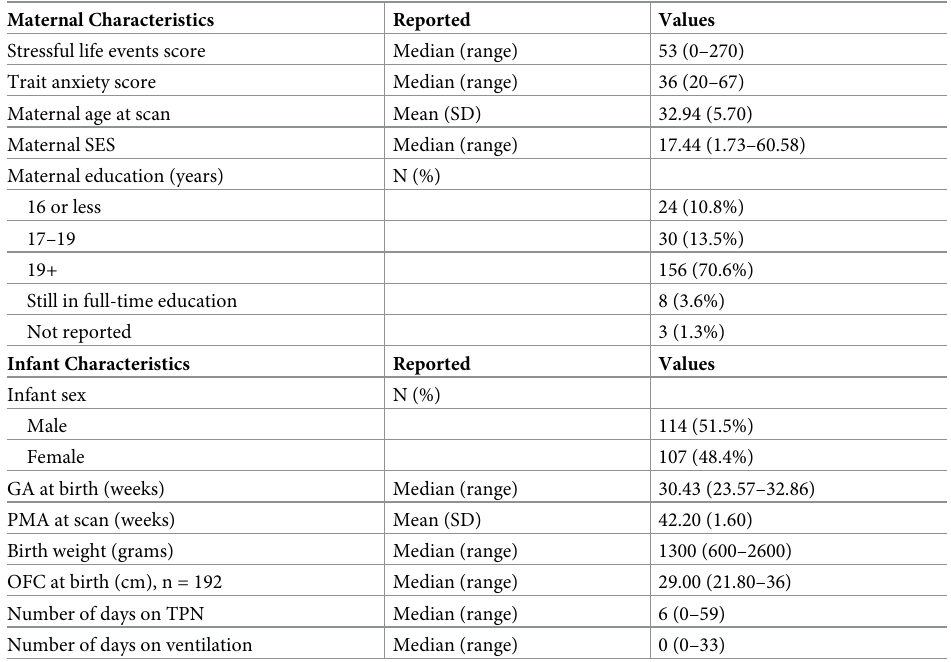
Table 1. Obstetric and sociodemographic characteristics (n = 221).